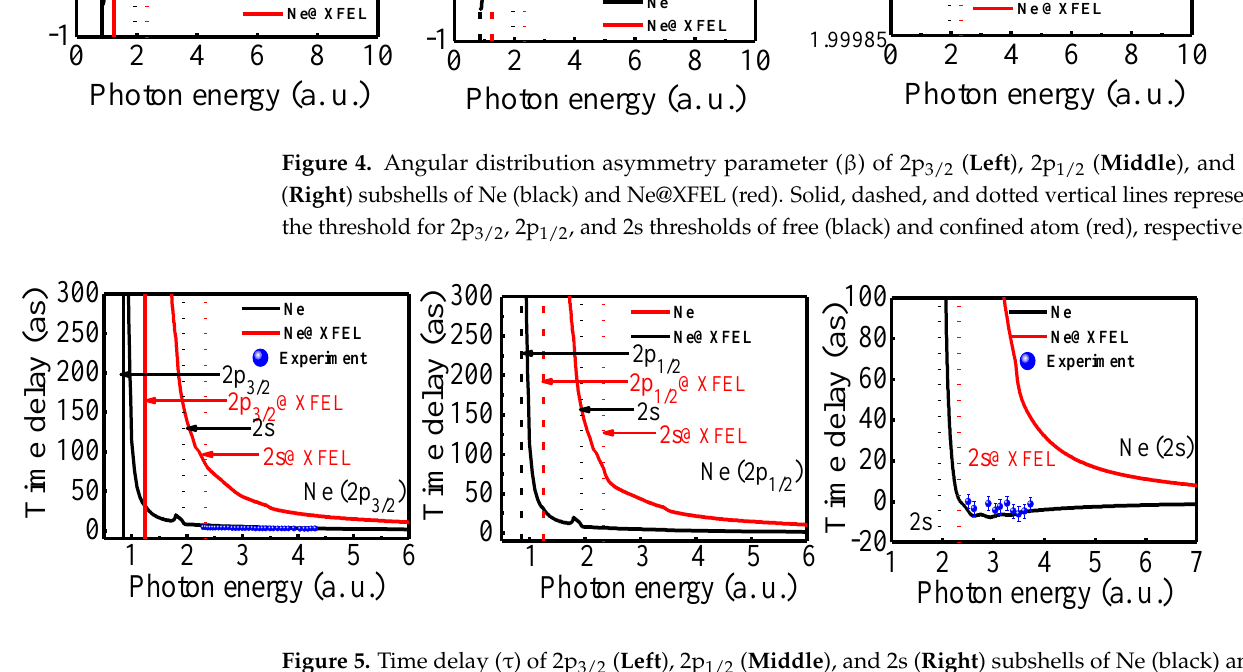
Figure 5. Time delay (τ) of 2p 3/2 (Left), 2p 1/2 (Middle), and 2s (Right) subshells of Ne (black) and Ne@XFEL (red). Solid, dashed, and dotted vertical lines represent the threshold for 2p 3/2 , 2p 1/2 , and 2s thresholds of free (black) and confined atom (red), respectively. Blue scattered points in left and right panel of the figure show the experimental results [47].